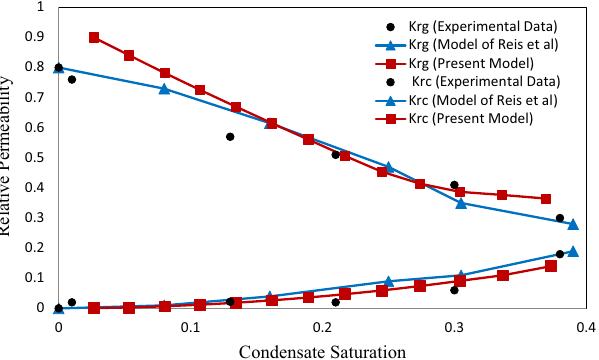
Figure 12. Relative permeability versus saturation at velocity of 36 m/day and IFT = 0.015